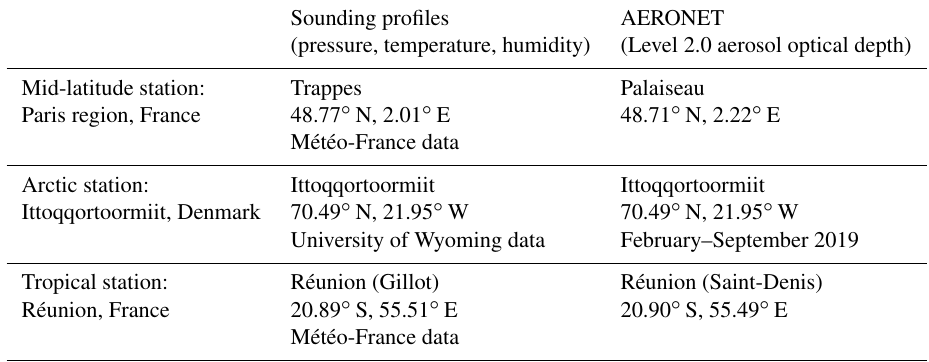
Table A1. Overview of atmospheric sounding and AERONET sites used to derive an atmosphere model for the sensitivity analysis. For all sites data from 2019 were used. Note that for the arctic station, AERONET photometer products are from February until